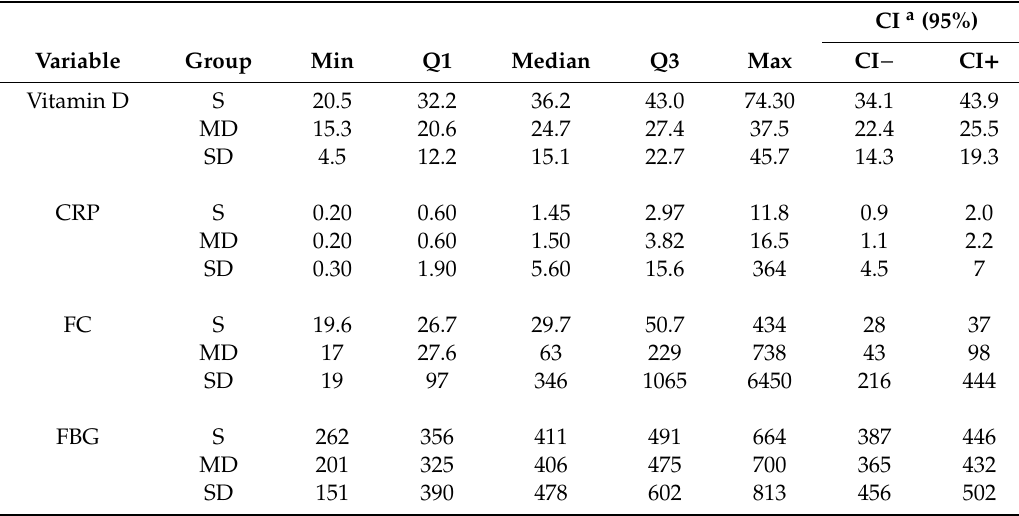
Table 2. Robust statistical parameters obtained from vitamin D and inflammatory markers grouped according to vitamin D